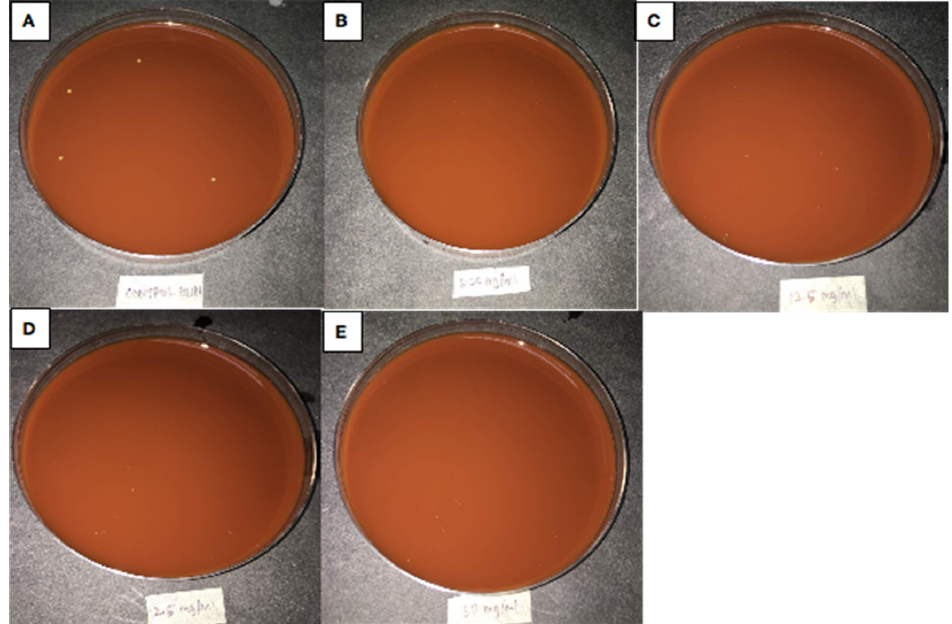
Figure 4. H. influenza . Negative control ( A ). 6.2 mg/mL TiO 2 containing 0.03% silver ( B ). 12.5 mg/mL TiO 2 containing 0.03% silver ( C ). 25 mg/mL TiO 2 containing 0.03% silver ( D ). 50 mg/mL TiO 2 containing 0.03% silver ( E ). It should be noted that there was no bacterial growth observed on the chocolate blood agar plates ( B – E ).